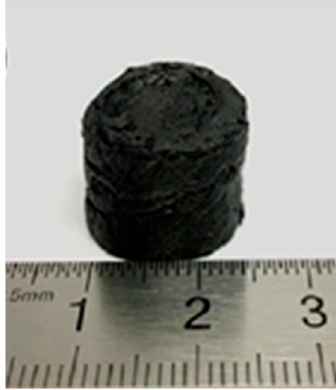
Figure 7. Digital image of the g-C 3 N 4 /GO aerogel. Adapted with permission from [102]. Copyright © 2017 Elsevier.